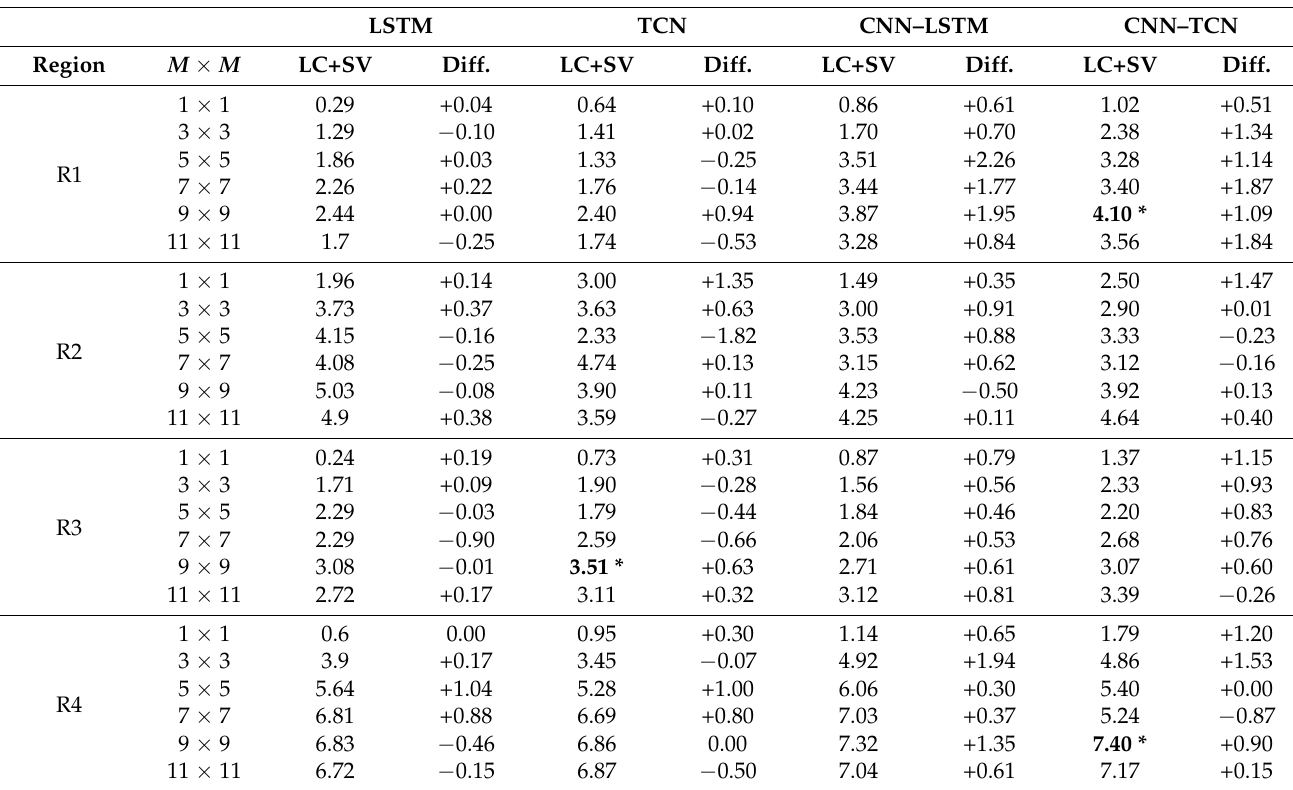
Table 7. Figure of Merit (FOM) values obtained for (R1) the Regional District of Bulkley-Nechako, (R2) the Regional District of Central Kootenay, (R3) the Northern Rockies Regional Municipality, and (R4) the Cariboo Regional District. “LC+SV” refers to the model configuration provided the added spatial variables input (Figure 3), with differences between FOM values in Case 2 shown under the respective “Diff” columns for each model type. Values in bold and with * indicate the FOM is highest for the region across Cases 2 and 3. Effect of Adding Spatial Variables on Figure of Merit (%) LSTM TCN CNN–LSTM CNN–TCN